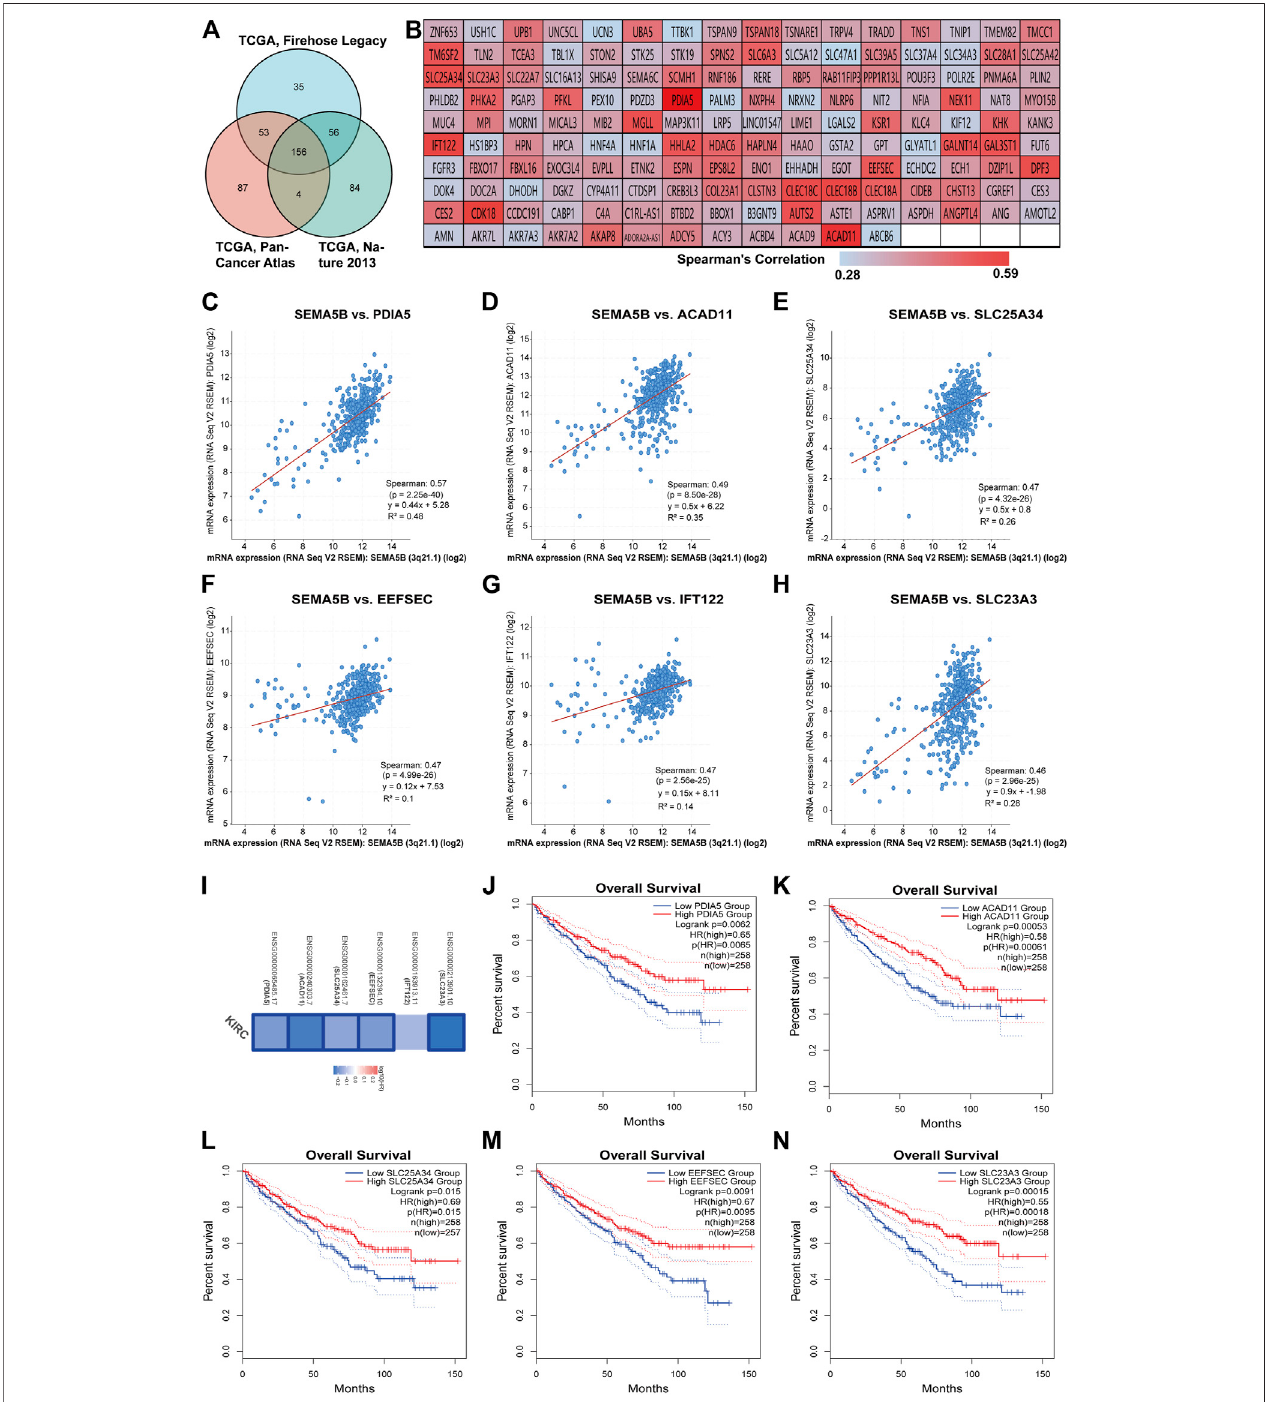
FIGURE 4 | Analyses of genes co-expressed with SEMA5B. (A) The Venn diagram of the 156 co-expressed genes in three TCGA studies on KIRC. (B) The heat mapofthecorrelationbetweenSEMA5Bandits156co-expressedgenesaccordingtothevaluesofSpearman ’ srankcorrelationcoef fi cient. (C – H) Scatterplotshowing the correlation between SEMA5B and its top six co-expressed genes. (I) Survival map of the six co-expressed genes based on the TCGA – KIRC project data was generated with the GEPIA2 online tool. Blue boxes indicate statistically signi fi cant genes. (J – N) The K-M (Kaplan – Meier) plots of overall survival (OS) shows the difference between the low- and high-expression of (J) PDIA5, (K) ACAD11, (L) SLC25A34, (M) EEFSEC, and (N) SLC23A3 in KIRC.